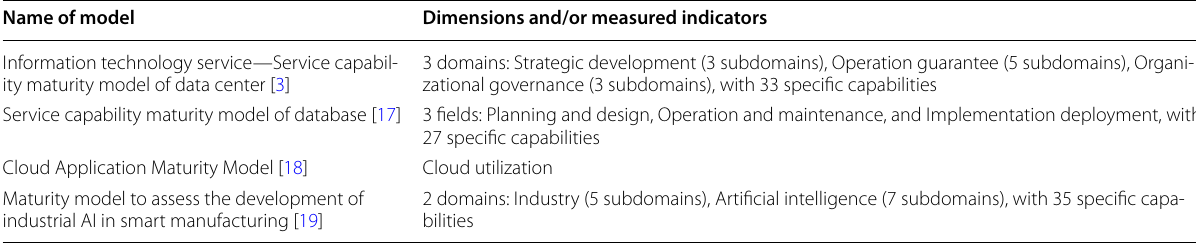
Table 1 Relevant maturity models in the context of our study Name of model Dimensions and/or measured